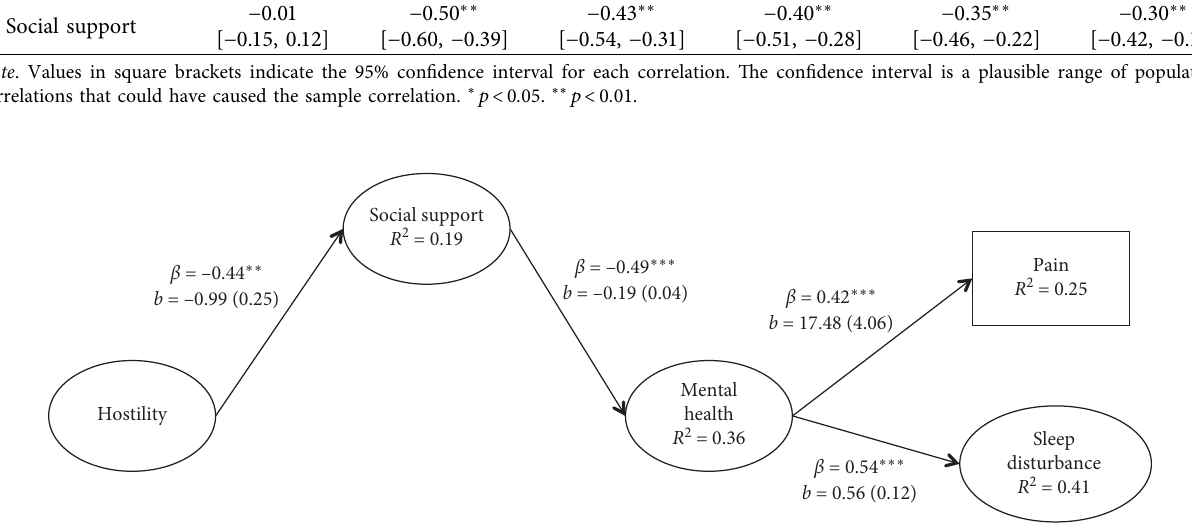
Figure 1: Model testing study hypotheses. Note . Unstandardized coefficients are represented by b and standardized coefficients are represented by β . Standard errors are displayed in parentheses next to the unstandardized coefficients. Nonstatistically significant paths are not shown. ∗ p < 0 . 05. ∗∗ p < 0 . 01. ∗∗∗ p < 0 .